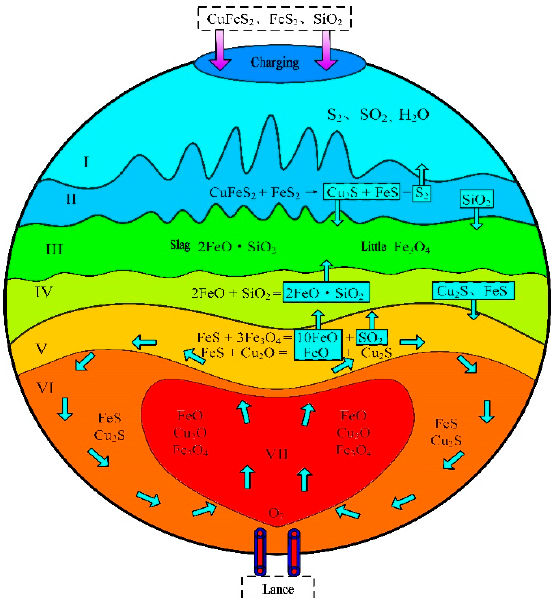
Figure 2. SKS mechanism model-I.